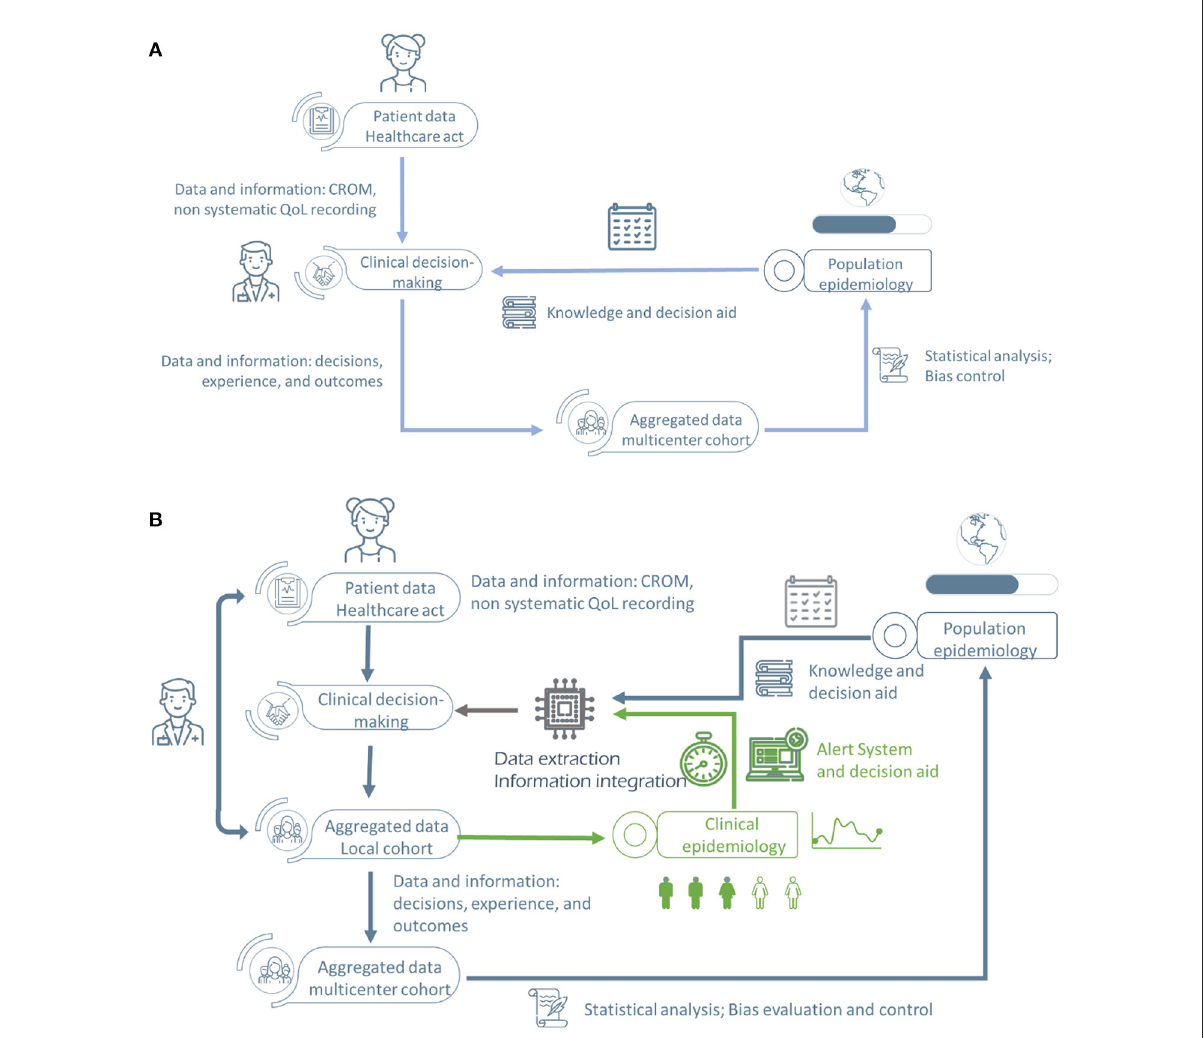
FIGURE1 Epistemological change and redesigned Healthcare Information Systems (HIS) within the requisites of the RWE paradigm. (A) Traditional medical epistemological paradigm. (B) New medical epistemological paradigm with “real-time” incorporation of the scientific evidence produced during the healthcare act [QoL, Quality of Life; RWE, Real World Evidence; CROM, clinician-reported outcome measures (clinical